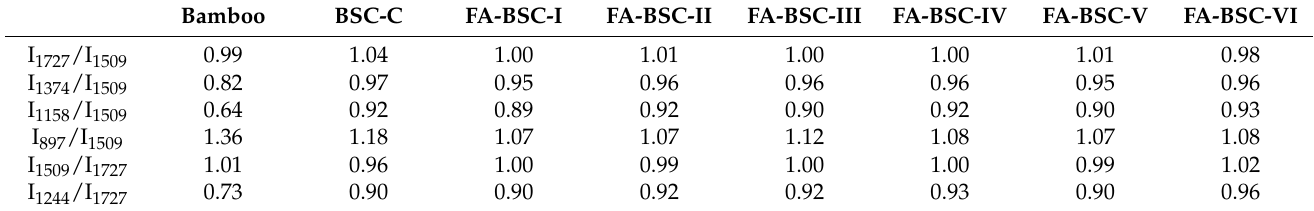
Table 6. Ratios of the intensities of lignin-associated bands to those of carbohydrate bands for BSCs.